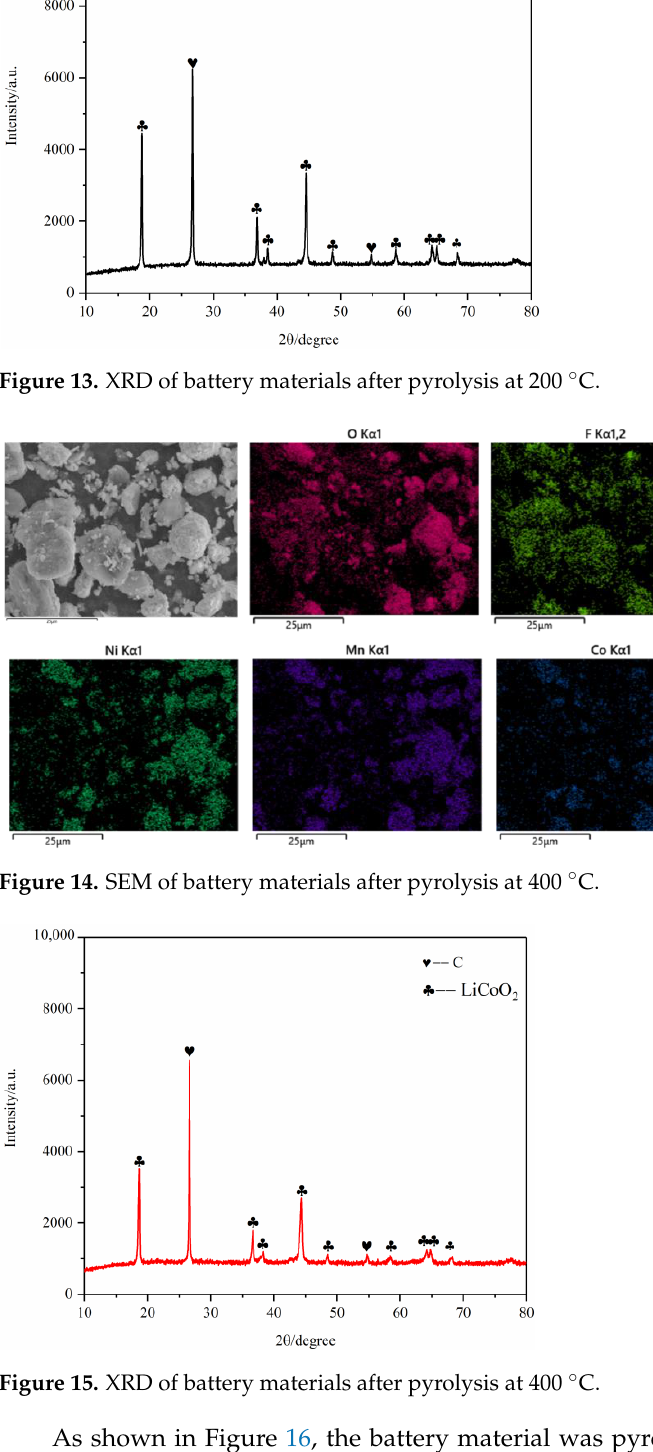
Figure 13. XRD of battery materials after pyrolysis at 200 °C.